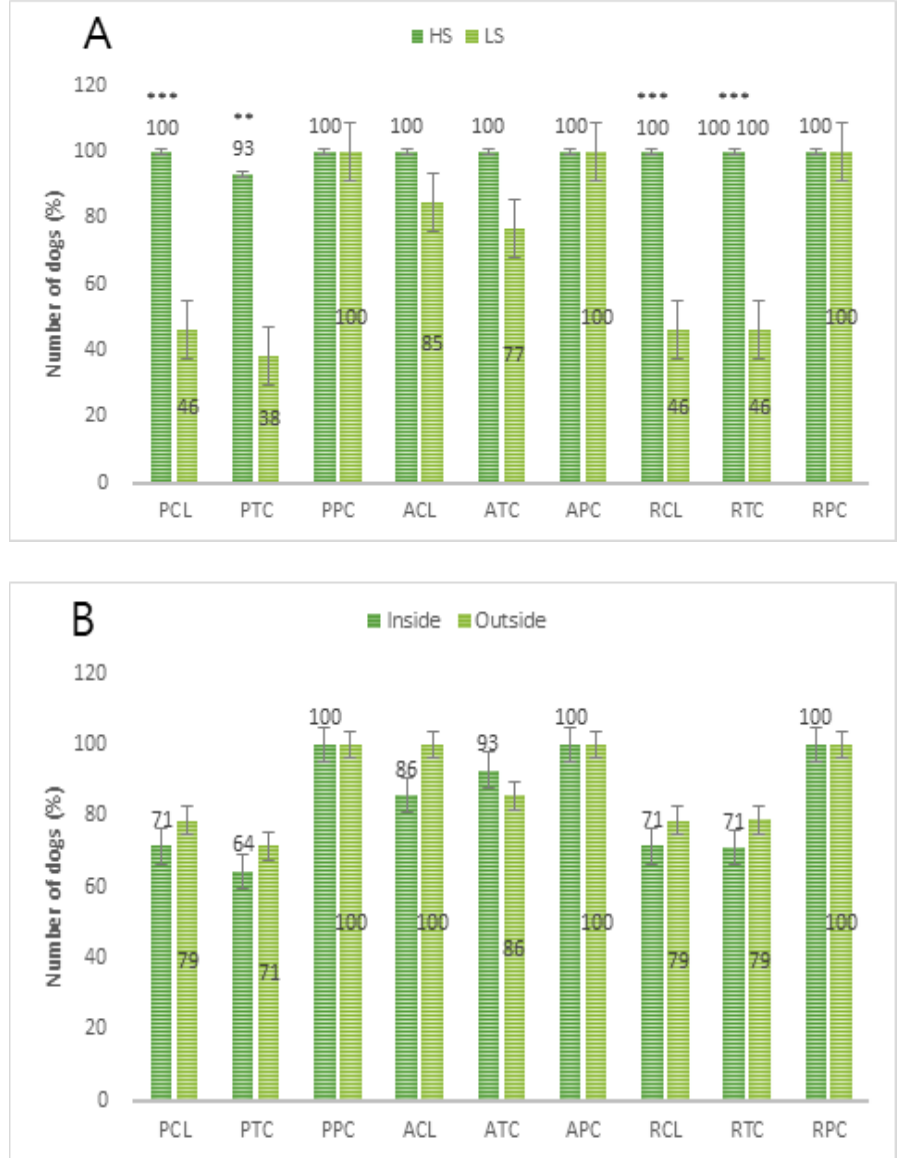
Figure 2. Behavioral changes in dogs in the 9 social behavior test categories. ( A ): Comparison between high sociality (HS) group and low sociality (LS) group, Levels of significance: ** p <0.01; *** p <0.001. ( B ): Comparison between the living mostly inside (IS) group and the living mostly outside (OS) group. PCL, contact latency of passive phase; PTC, time close to the trainer of passive phase; PPC, physical contact time of passive phase; ACL, contact latency of active phase; ATC, time close to the trainer of active phase; APC, physical contact with the trainer of active phase; RCL, contact latency of food reinforcement phase; RTC, time close to the trainer of food reinforcement phase; RPC, physical contact with the trainer of food reinforcement phase.